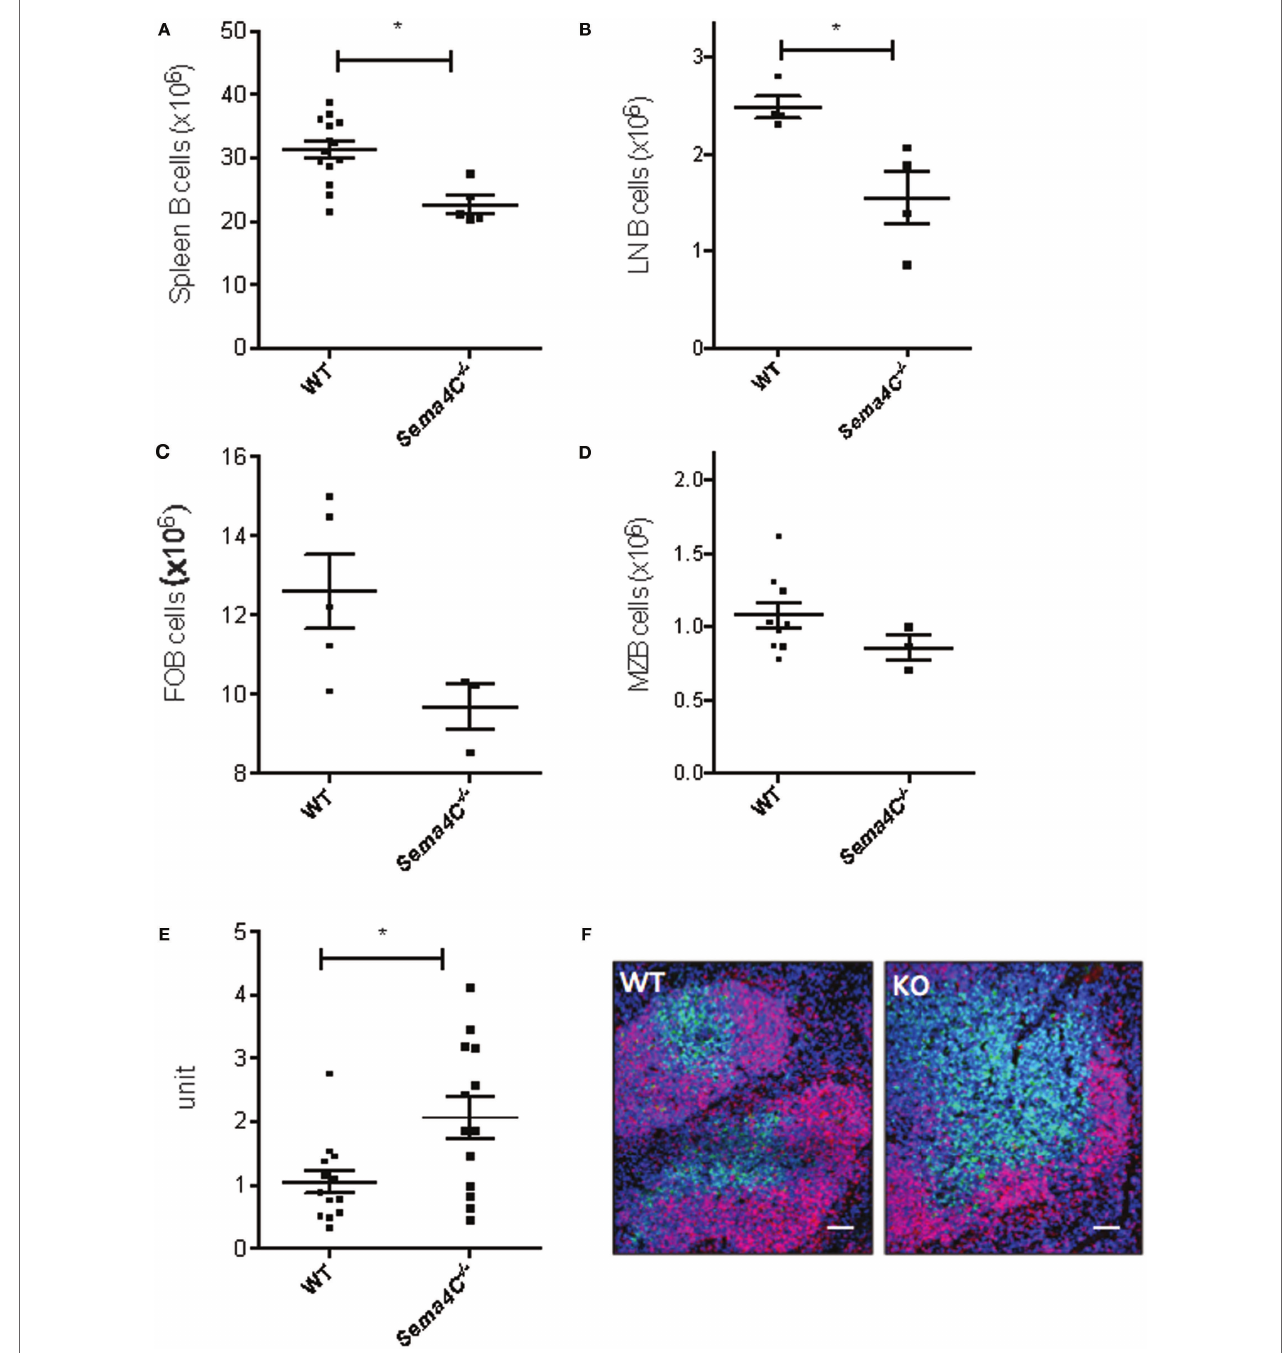
FigUre 2 | sema4c − / − mice have decreased B-cells in secondary lymphoid organs and abnormal splenic organization . (a–D) Sema4C − / − mice had decreased B-cells in secondary lymphoid organs. Total B cell counts in spleen (a) and cervical lymph nodes (B) , follicular B-cells (c) and marginal zone B-cells (D) from naïve Sema4C − / − or littermate WT mice were determined by flow cytometry. B-cells were defined as CD19 + CD3 − , follicular B-cells: CD19 + CD93 − CD21 − CD23 + IgM Low IgD High , marginal zone B-cells: CD19 + CD93 − CD21 + CD23 − IgM High IgD Low . (e,F) Sema4C − / − mice exhibit abnormal secondary lymphoid organ follicular structure. (e) Size of splenic follicles in naïve Sema4C − / − or WT mice, measured by ImageJ. Each dot indicates one follicle and follicles were randomly selected from five different mice. n = 5. (F) Representative immunofluorescence images of spleens from naïve Sema4C − / − or WT mice stained for CD19 (red), CD3 (green), and nuclei (blue). Data shown are representative of five mice. Images showing Sema4C − / − mice had larger follicles as well as poor demarcation between T- and B-cell margins. Scale bar: 200 μ